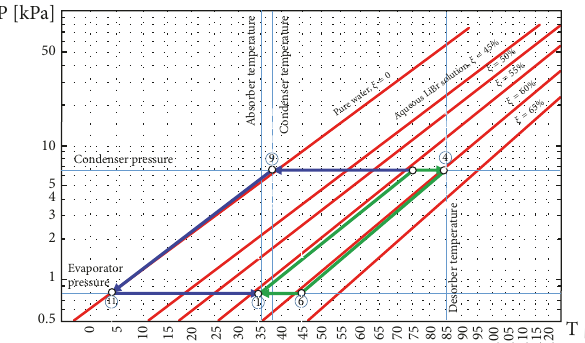
Figure 4: Chiller cycle representation in the Oldham-diagram (𝑇 𝑆𝐺 ≈ 200 ∘ C ;𝑇 𝐺 = 85 ∘ C ; 𝑇 𝐸𝑉 = 4 ∘ C ; 𝑇 𝐶𝐷 = 37 ∘ C ) .